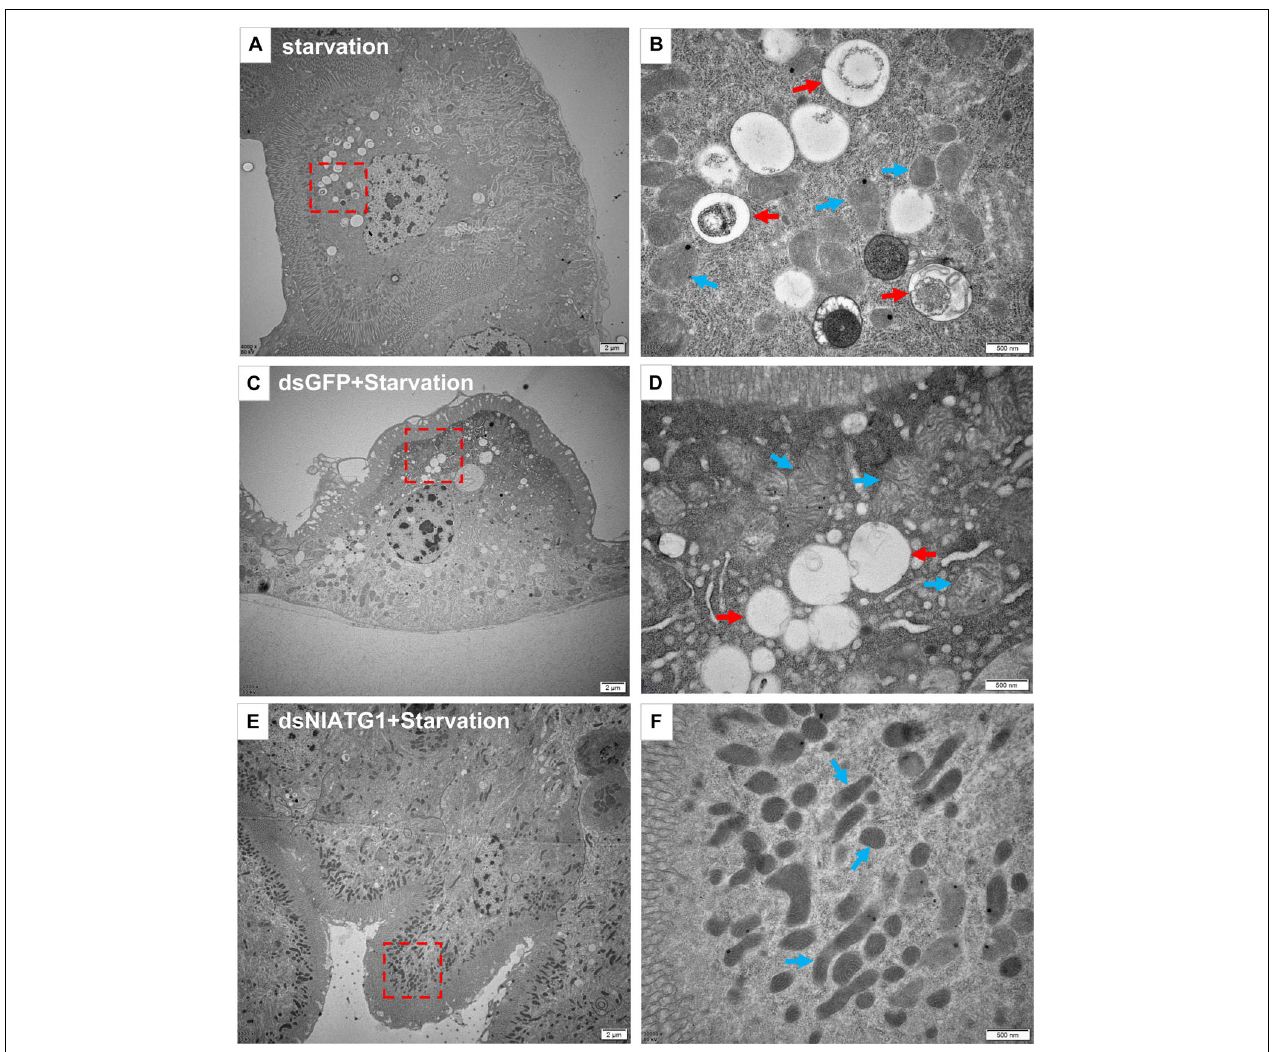
FIGURE 5 | Transmission electron microscopy graphs of midgut cells. (A,B) The control group of the starvation treatment at 48 h; (C,D) starvation treatment at 48 h after injecting dsGFP for 4 days. (E,F) starvation treatment for 48 h after injecting dsNlATG1 for 4 days. Red arrows denote autophagic vacuoles or compartments, while blue arrows denote the mitochondria. (B , D) and (F) represent enlargements of the parts indicated by red dotted boxes in (A , C) and (E) , respectively. Scale bars: (A,C,E) 2 µ m; (B,D,F) 500 nm. At least three biological replicates were used per